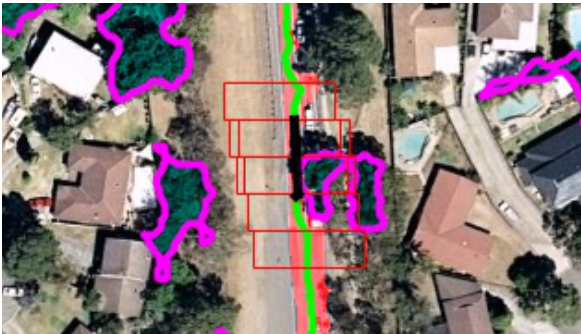
Figure 5: Image of extrapolation search (red rectangles) for se- lected road branches (green)